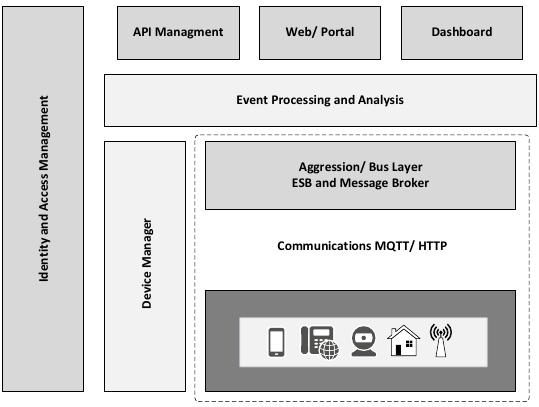
Figure 5. Web Service Oxygen (WSO2) IoT reference architecture [47].